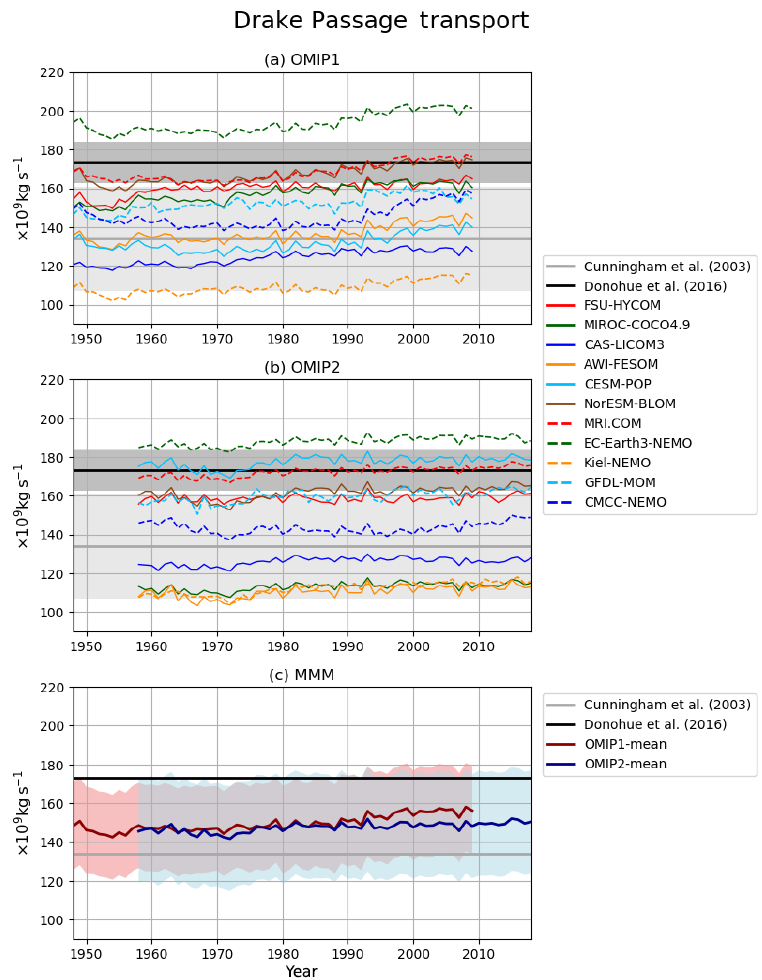
Figure 20. Same as Fig. 19 but for the Drake Passage transport (positive eastward), which represents the strength of Antarctic Circumpolar Current. Units are 10 9 kgs − 1 . Observational estimates are due to Cunningham et al. (2003) 134 ± 27Sv (1Sv = 10 9 kgs − 1 ) and Donohue et al. (2016) 173 . 3 ± 10 .